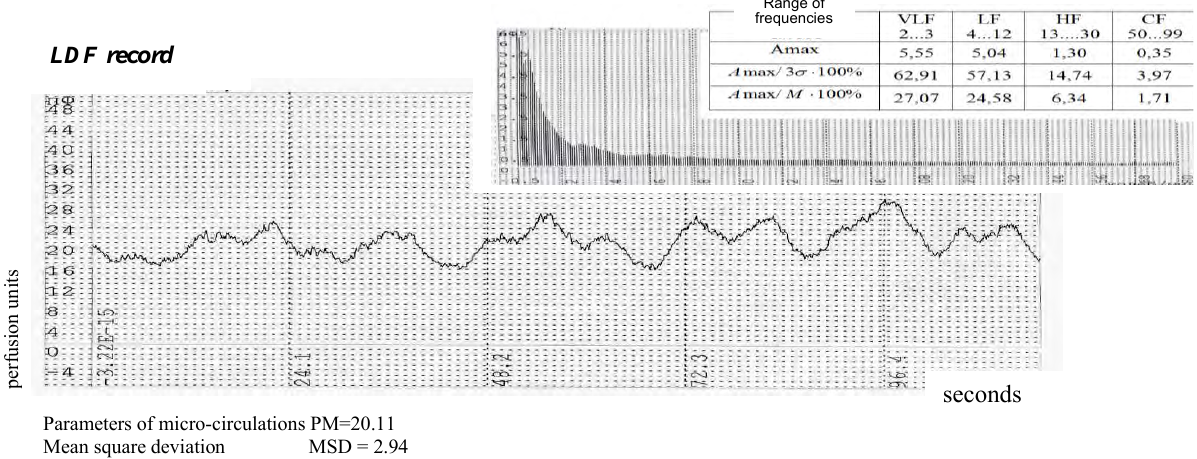
Fig.3. Daily monitoring of LDF record of 17 years old girl with standard type of micro-circulation at 4 p.m. By 4 p.m. PM and MSD increase. In AFV metabolic component of vasomotor oscillations (VLF rhythm) substantially increases. At evening period PM reduces and MSD (characterizing flux level) significantly rises. Against